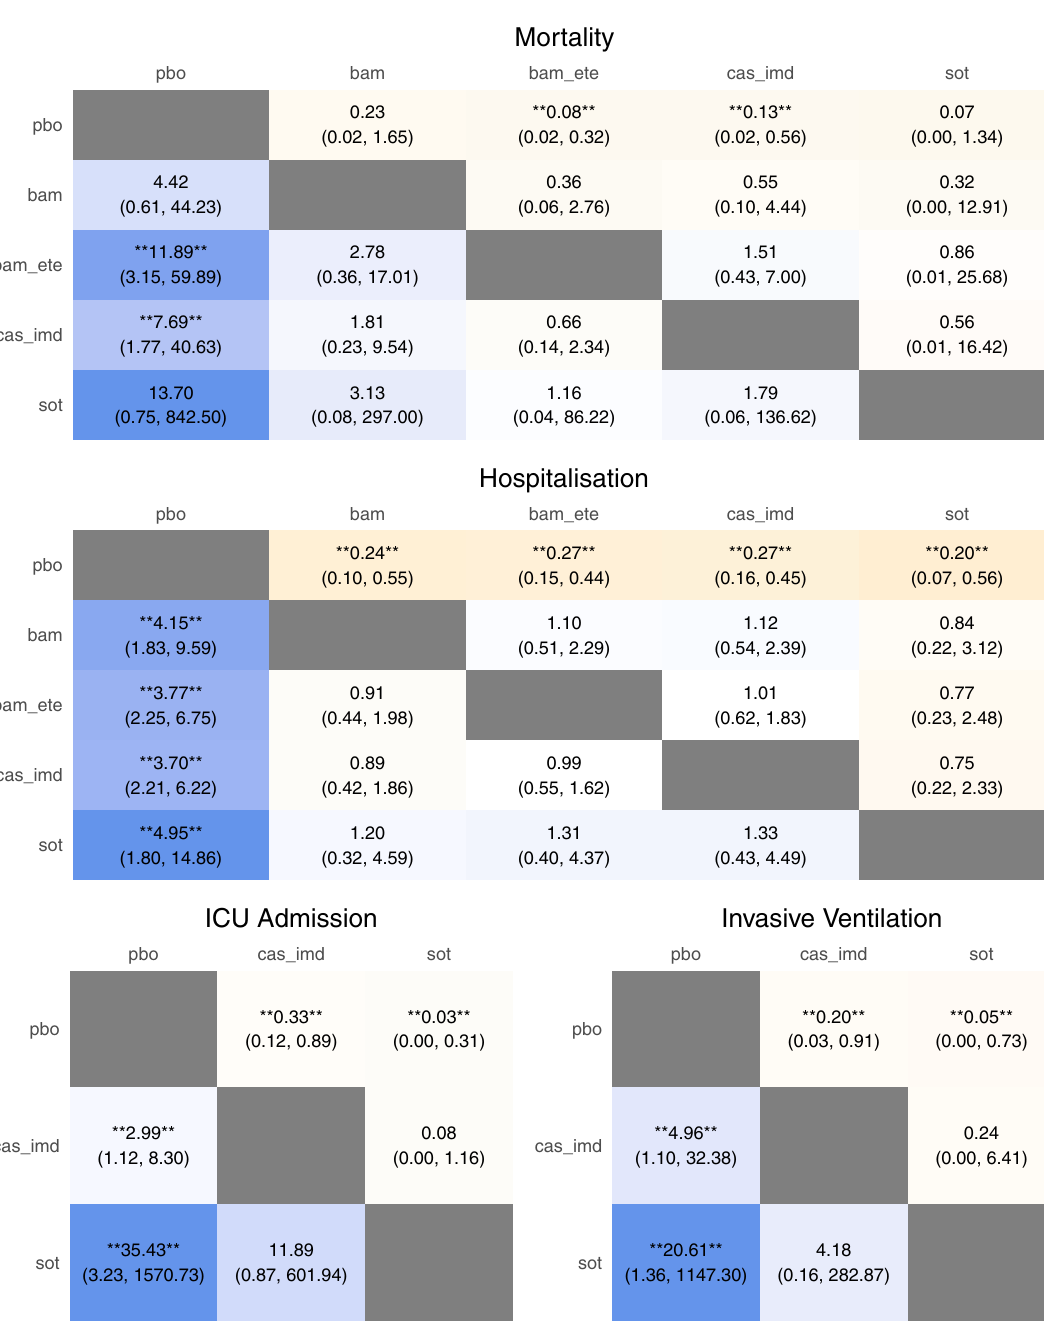
Figure 5. NMA results showing relative risks for all pairwise comparisons for efficacy outcomes (posterior median and 95% credible interval). Notation: pbo, placebo; bam, bamlanivimab; bam_ete; bamlanivimab/ etesevimab; cas_imd, casirivimab/imdevimab; sot, sotrovimab. For each pairwise comparison, posterior median and 95% credible interval are shown for the estimated relative risk. Values of greater than one indicate that the given event is more frequent for the intervention (column name) than the comparator (row name). A double asterisk (**) in a given cell indicates that the corresponding comparison is statistically significant at the nominal 95% confidence level (i.e. without correction for multiple